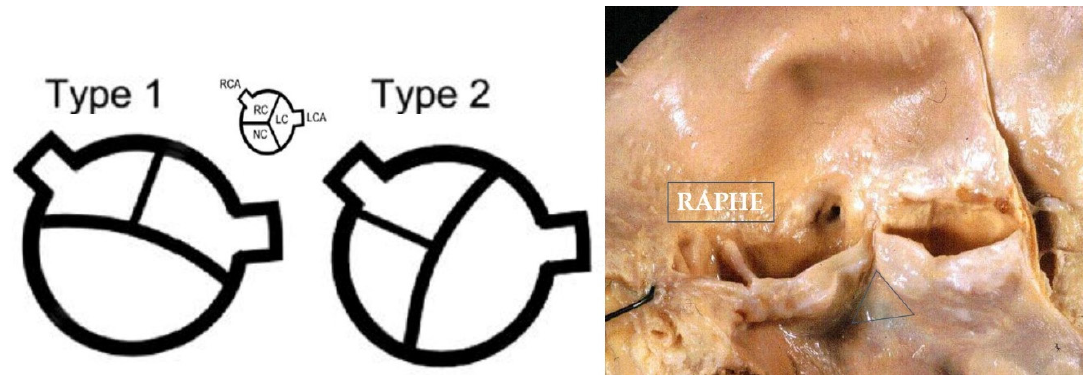
Figure 4. Bicuspid aortic valve, type 1 and 2. Note the raphe without the interleaflet triangle underneath. Natural history of BAV is characterized by progressive calcification of the cusps with aortic valve stenosis [10] and by aortopathy (Figure 5) with dilatation of the ascending aorta, valve incompetence and aortic dissection (Figure 6) [11–13].